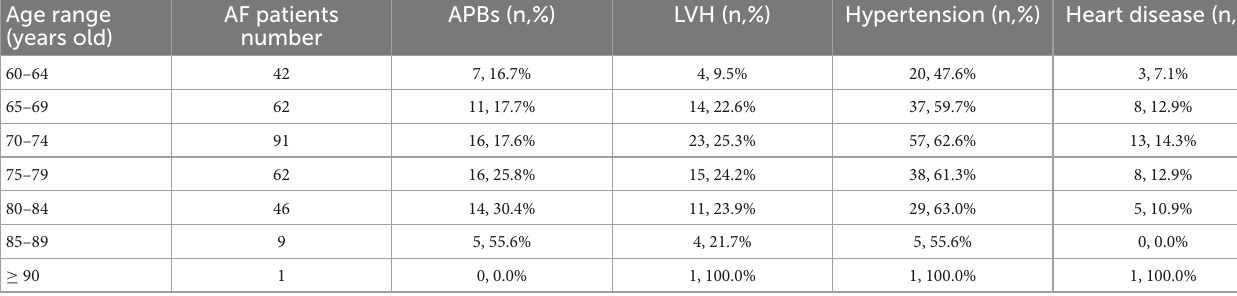
TABLE 12 The number and proportion of baseline characteristics for subjects with AF of different age ranges. Age range (years